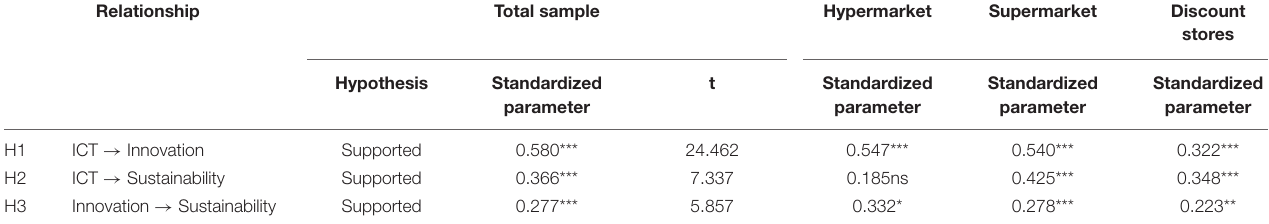
TABLE 5 | Causal relationships estimation.